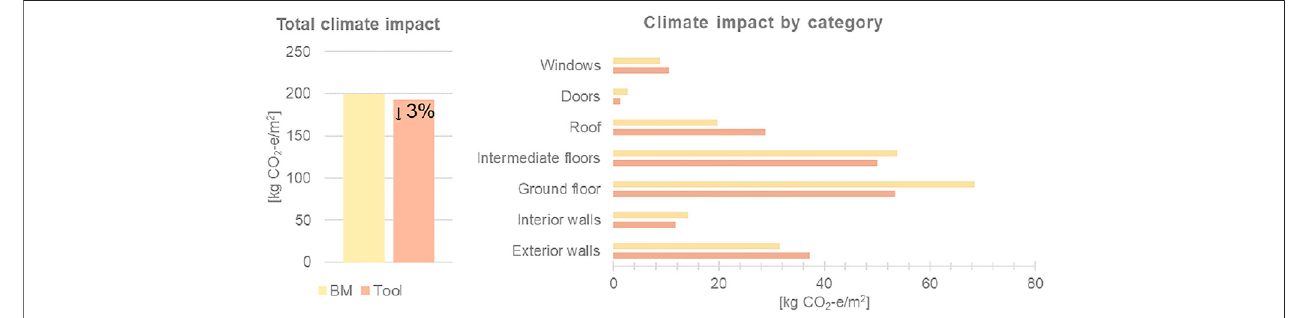
FIGURE 7 | Comparison of the results calculated in BM and in the